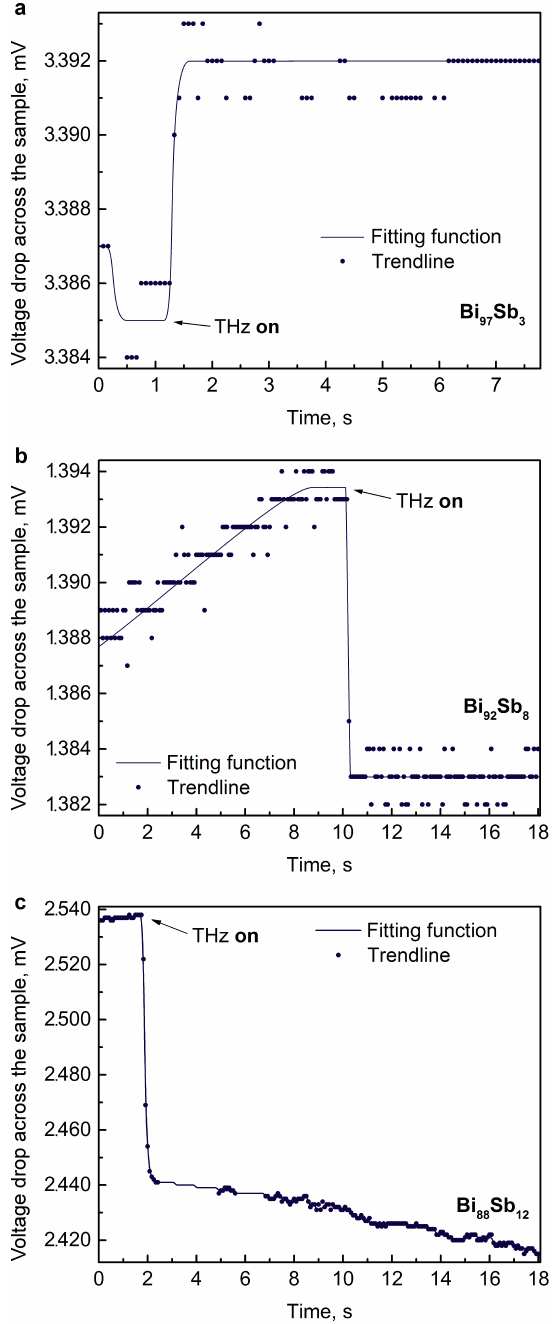
Figure 6. Second experiment (photoelectric effect). The temporal dependencies of voltage in 200 nm Bi 97 Sb 3 ( a ), Bi 92 Sb 8 ( b ), Bi 88 Sb 12 ( c ) films under the influence of direct current and THz radiation. The investigated effects appear most noticeably in Bi 88 Sb 12 sample, and they are impor- tant from the point of view of obtaining the highest detection efficiency of THz